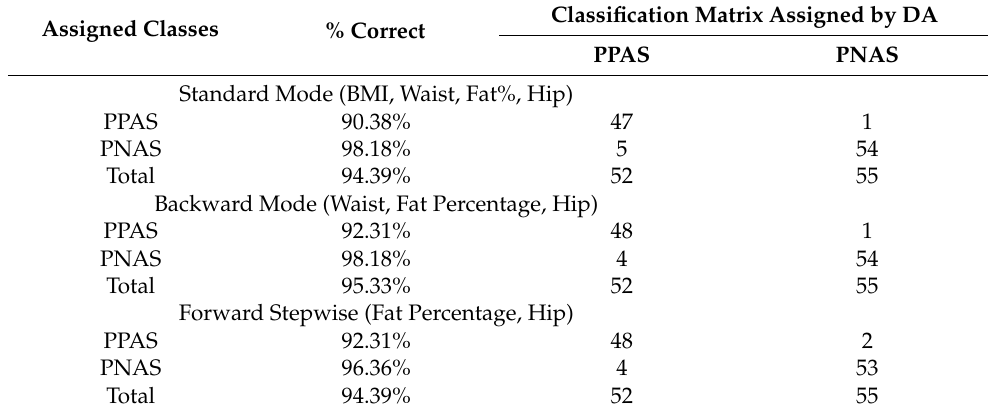
Table 4. The discriminant analysis model of the smoking